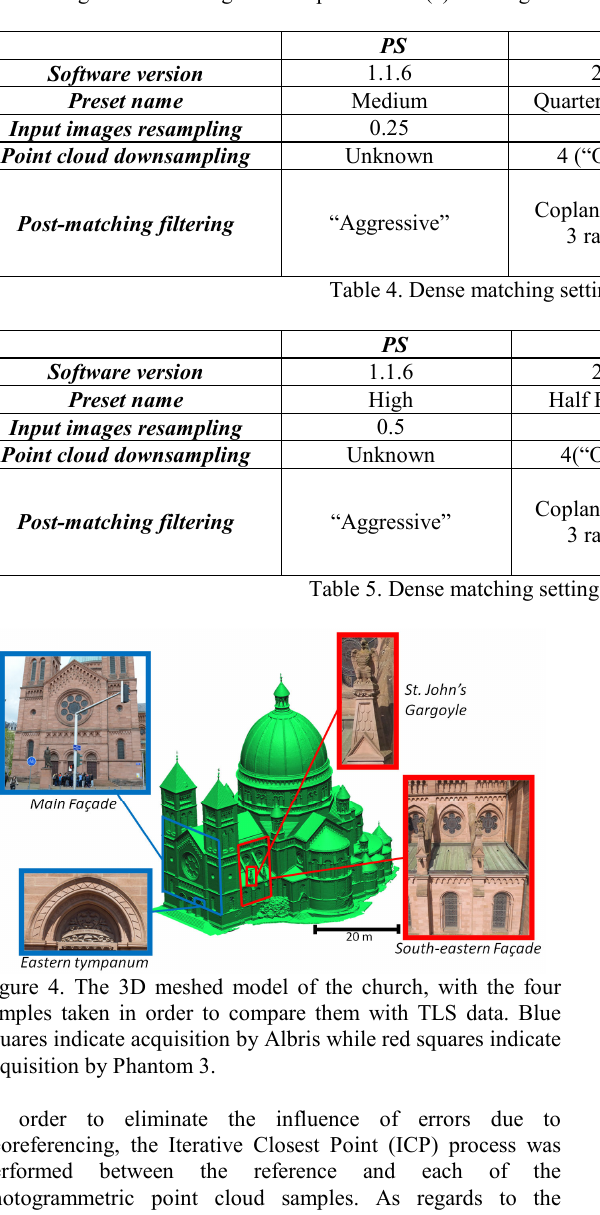
Figure 3. The merged dense point cloud (a) before global texturing and the final meshed and textured 3D model (b).